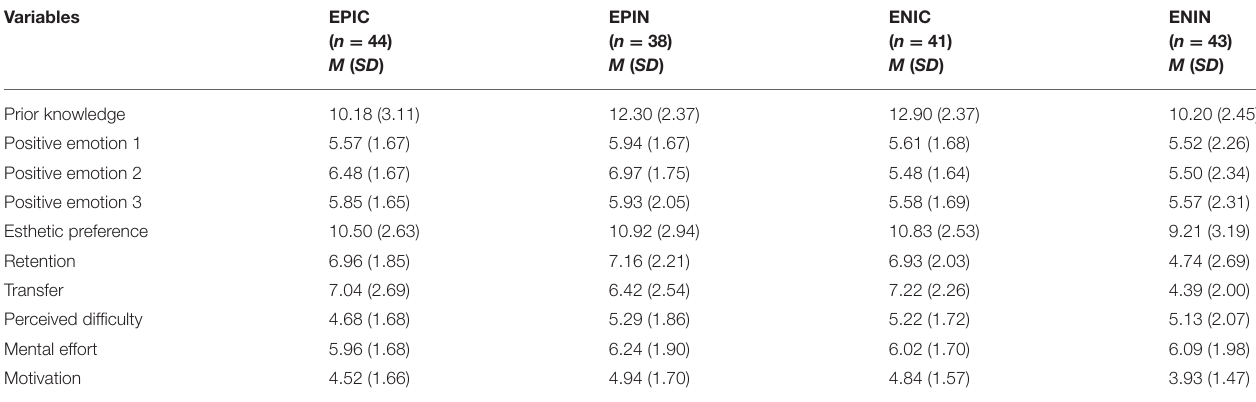
TABLE 2 | Means and standard deviations of all variables for the four groups in the formal